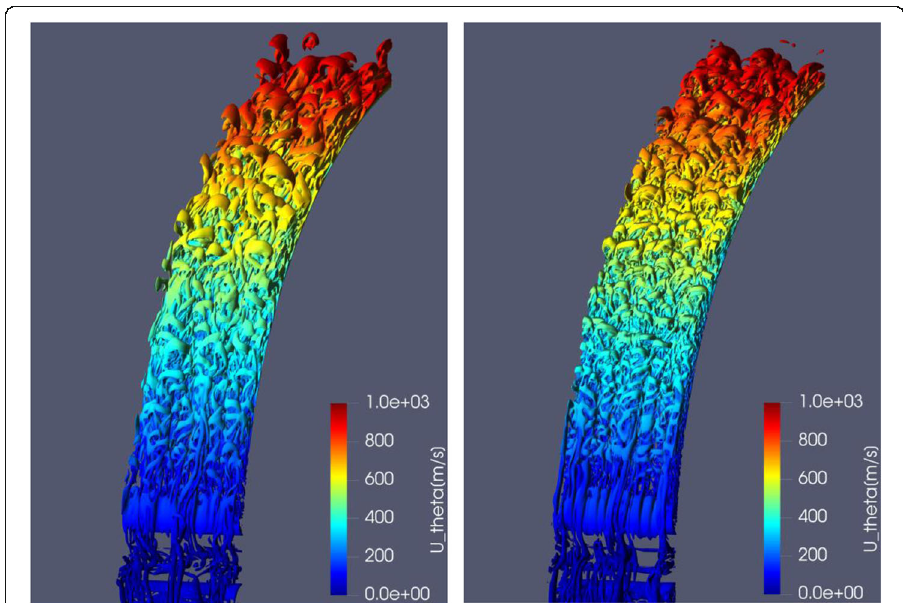
Fig. 12 Isosurface of Q-criterion. Left: (S1, Midst), Right: (S2, Midst)